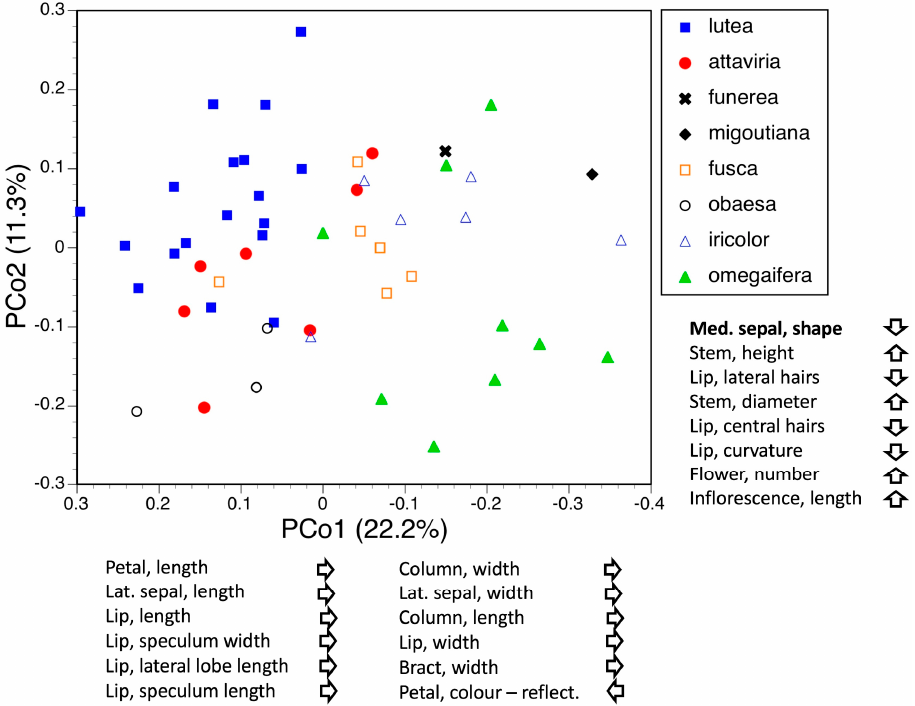
Figure 11. Plot of principal coordinates 1 and 2 for the macrospecies Fusca, labelled according to eight mesospecies groups: 51 individuals from 46 localities and 46 variable characters. Characters contributing to each coordinate are listed in descending order, with arrows indicating the direction of increase in the value of each character (boldface characters dominate that